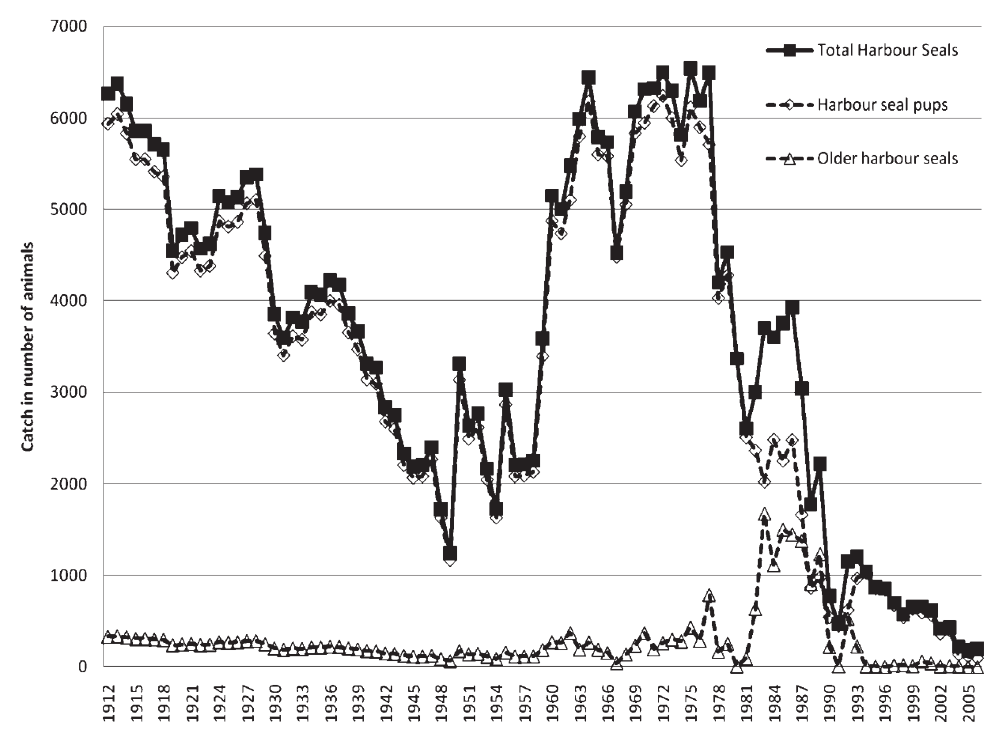
Fig. 1. The catch of harbour seals (Phoca vitulina) from 1912 to 2006, in Icelandic waters, divided between pups and 1+ animals. Figures from the logs of commercial seal skin dealers in the period 1962-1971 indicate that about 90% of the catch was harbour seal pups and about 5% was 1+ harbour seals (Arnlaugsson 1973), with harbour seals representing 95% of the catch and the remainder being grey seal pups. This was used to estimate harbour seal pup catch and 1+ harbour seal catch from the total catch, for the years 1912 to 1961 and 1972 to 1977. Raw data is given in Appendix 1 in Hauksson and Einarsson